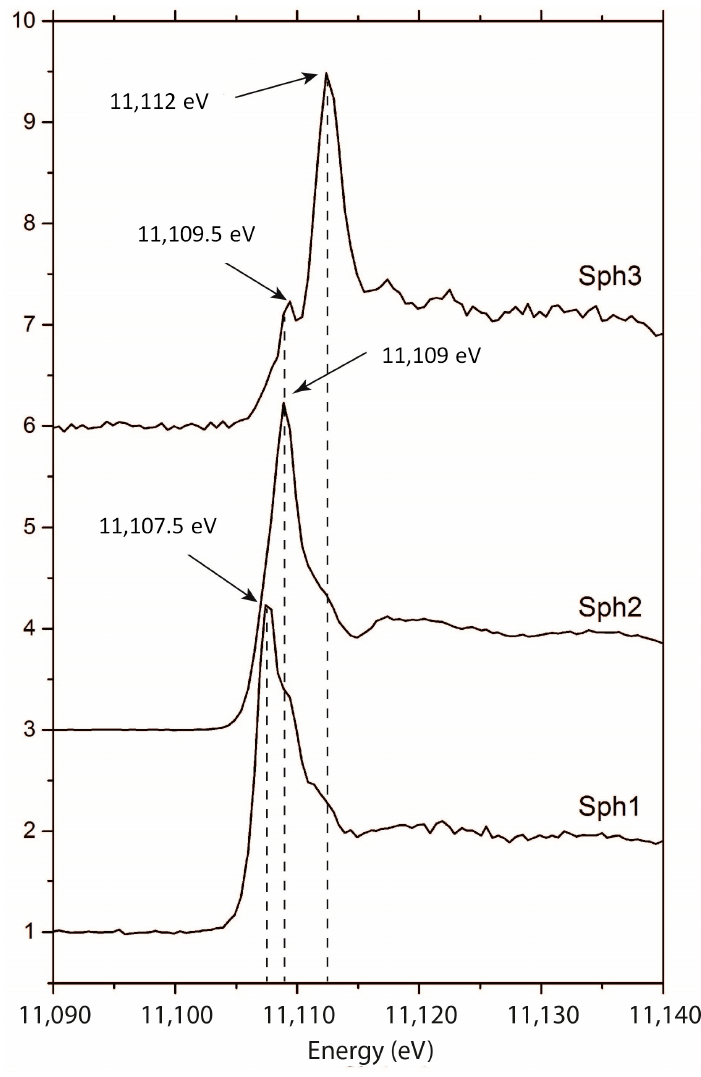
Figure 5. Spectra of the three end members found in the sphalerites samples. Sph1 with a peak at 11,107.5 eV; Sph2 with a peak at 11,109 eV; and Sph3 with a peak at 11,112 eV. All the other spectra measured on natural sphalerite from East and Central Tennessee can be modelled by a linear combination of Sph1, Sph2, and Sph3.